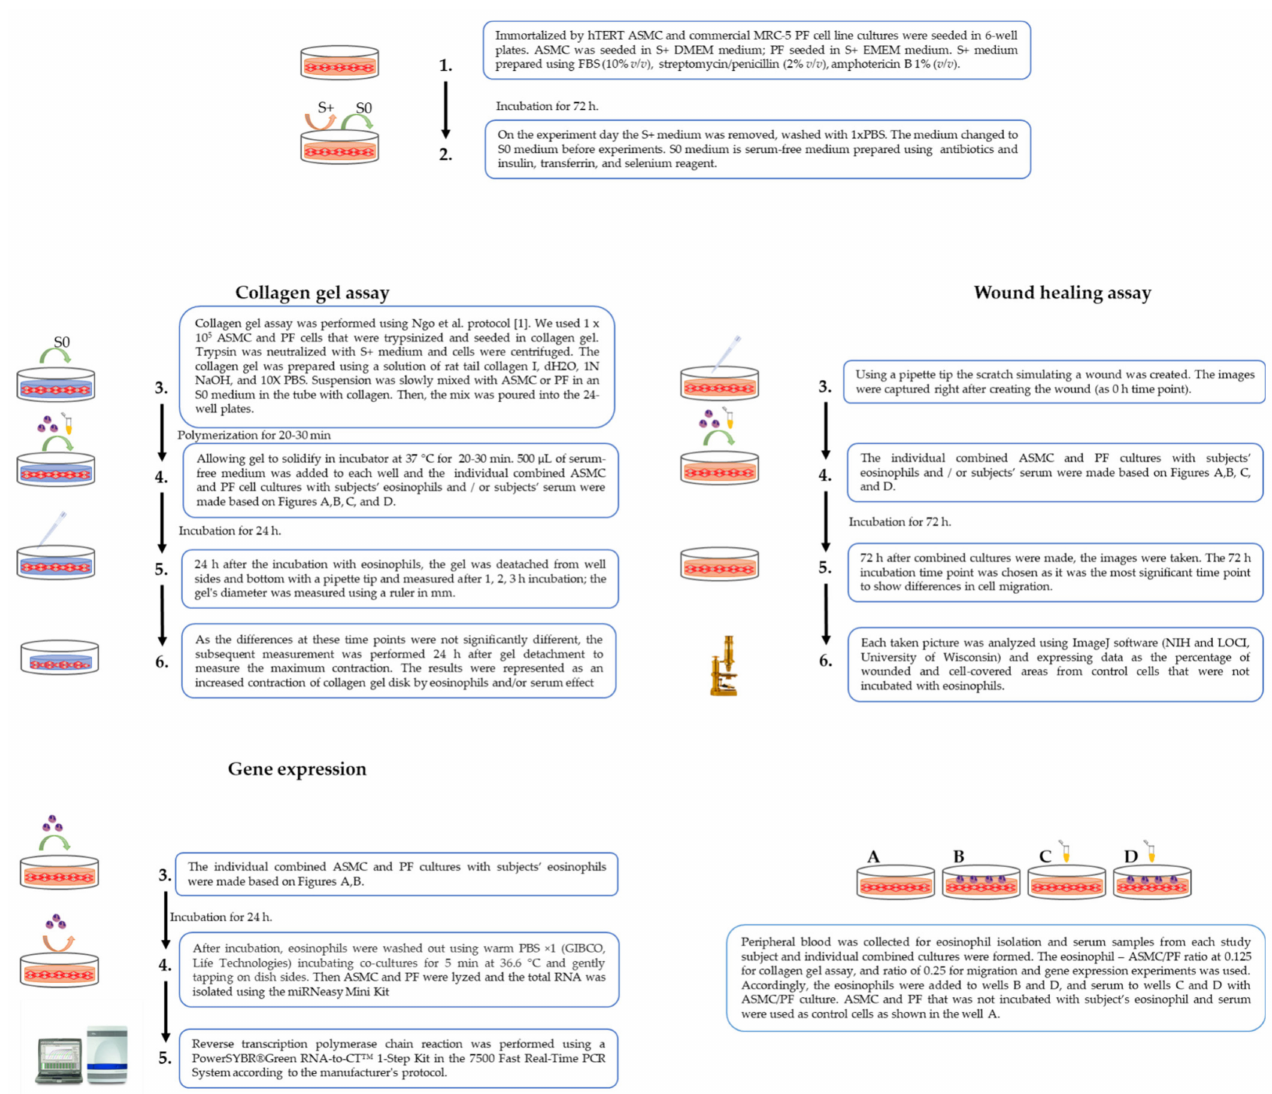
Figure 2. The detailed experimental plan. ASMC—airway smooth muscle cells; PF—pulmonary